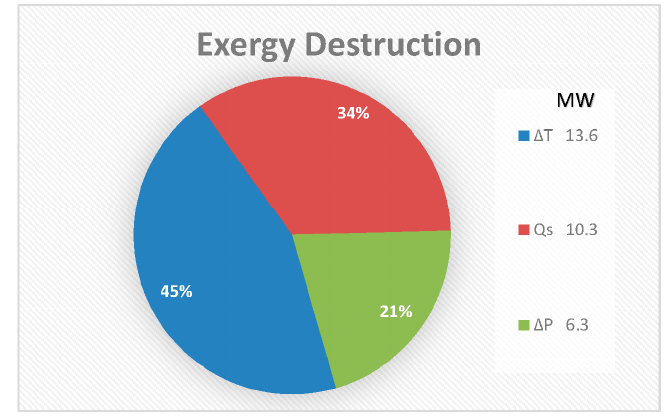
Figure 9. HRSG exergy destruction with different sources of Irreversibilities at ISO condition.